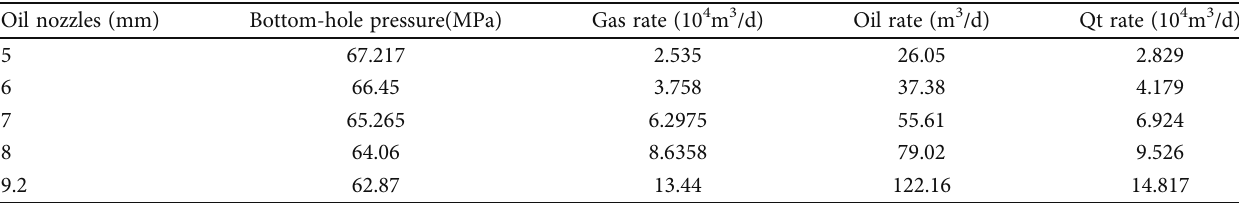
Figure 4: Fracture performance during di ff erent period [42]. Table 2: Measured data of productivity well